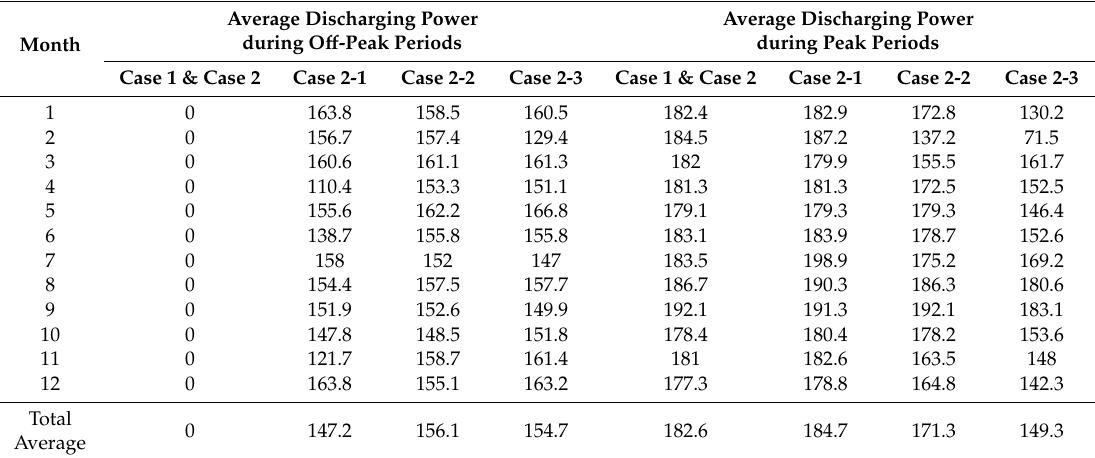
Table 5. Average monthly discharging power in o ff -peak and peak periods.